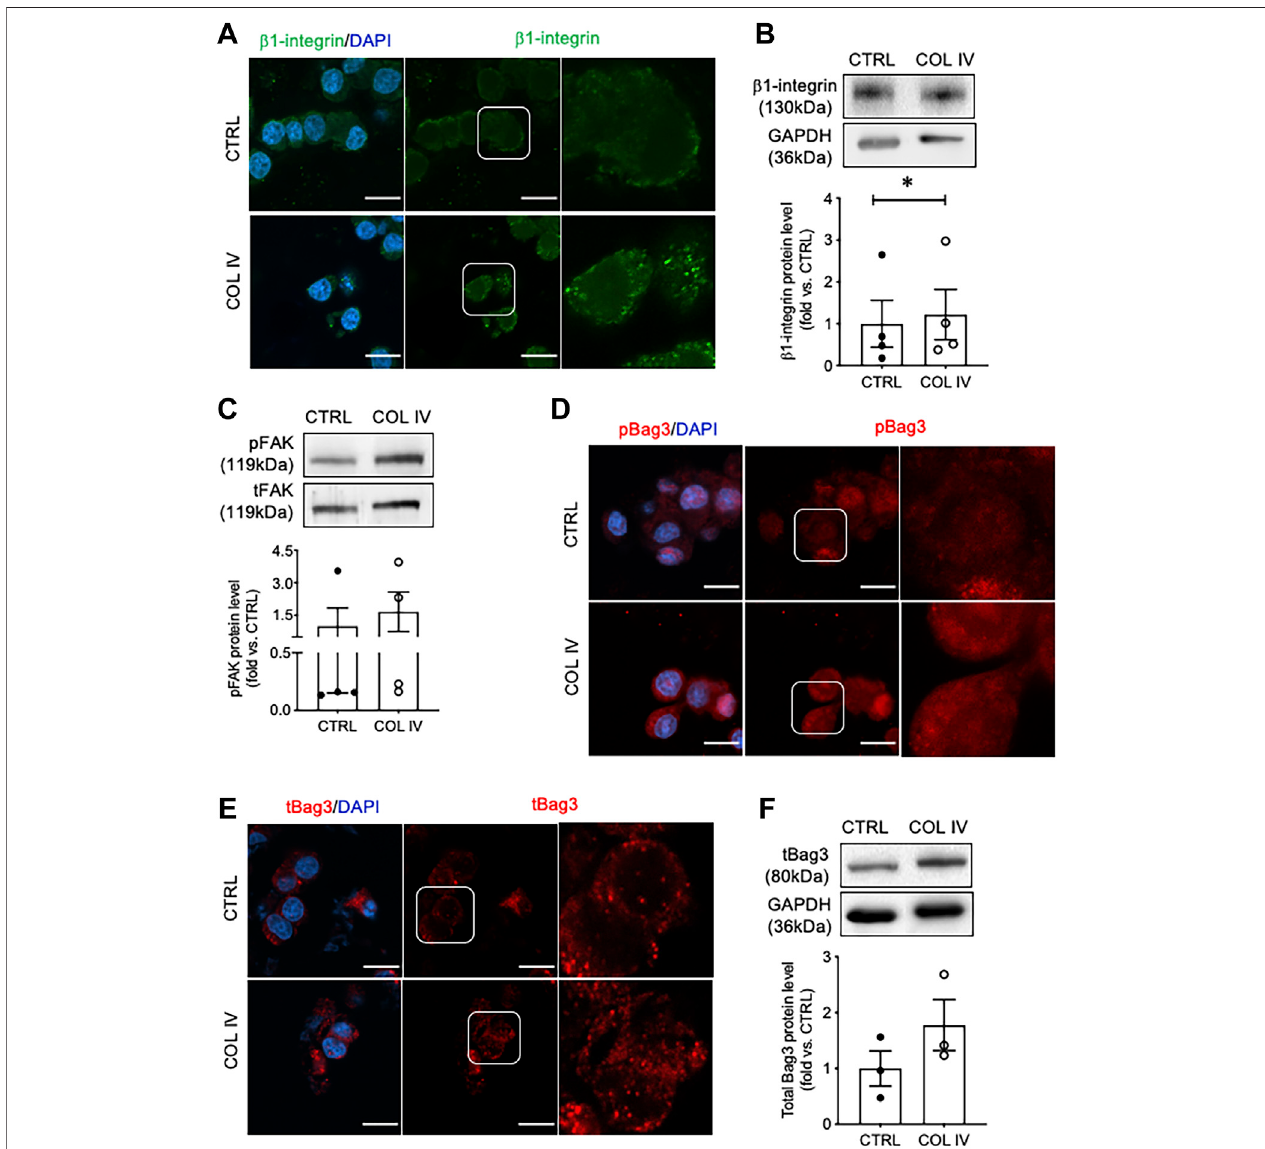
FIGURE2| CollagenIVenhances β 1-integrin,FAKandBag3phosphorylationinINS-1cells.Representative (A) β 1-integrin(green)immunostainingand (B) blotting image with data analysis; (C) phosphorylated FAK (pFAK) and total FAK (tFAK) blotting image and quanti fi ed data; representative immunostaining images for (D) phosphorylated Bag3(pBAG3, red), and (E) total Bag3 (tBag3, red) and (F) tBag3 blotting imageand blot data quanti fi cation in INS-1 cells cultured on collagen IV (COL IV) or BSA-coated control (CTRL). Nuclei are counterstained with DAPI, and magni fi ed images are highlighted. Scale bar: 10 µm. Data are expressed as mean ± SEM ( n = 3 – 4